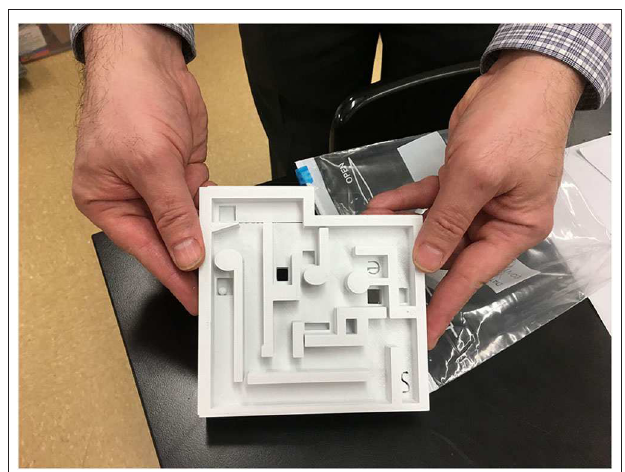
FIGURE 10 | Final